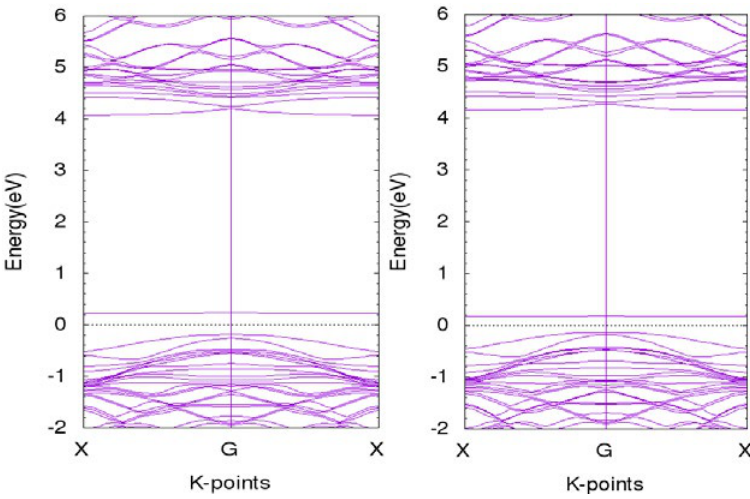
adsorbed and O adsorbed BN 2 3